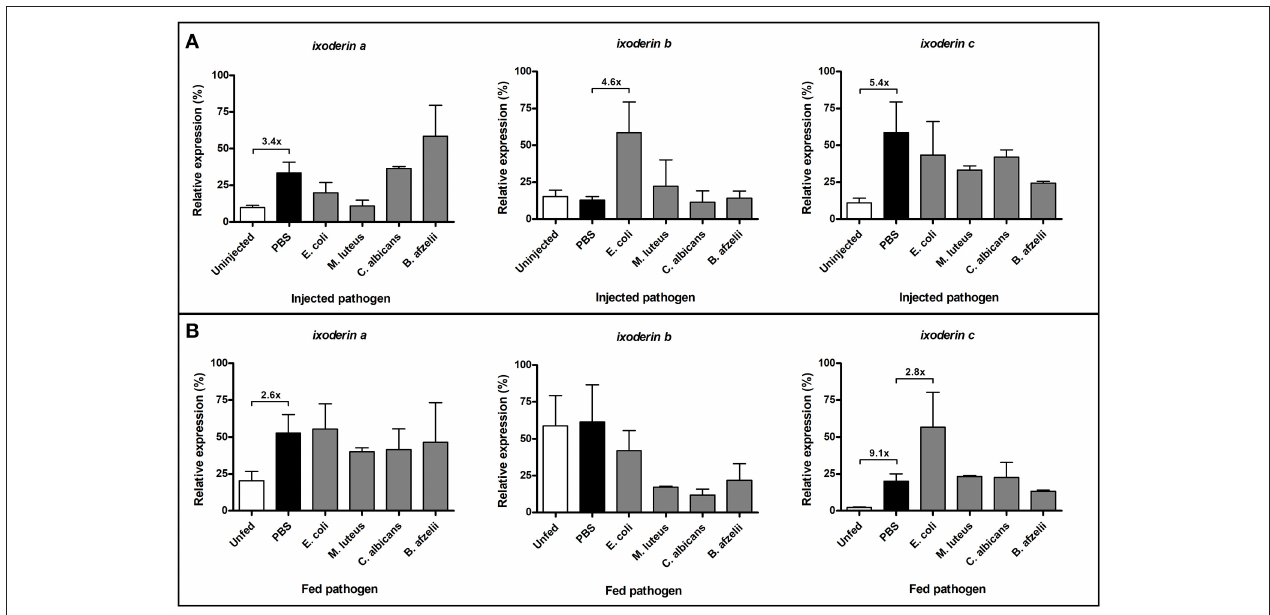
FIGURE 4 | Wounding and exposure to microbes alter expression of ixoderins . Gene expression was measured by qRT-PCR 12 hrs after pathogen injection or feeding. The analysis was performed using unfed adult females injected (A) or capillary fed (B) with pathogens. The samples were prepared in three biological replicates. In each graph, cDNA with the highest expression was set as 100% (relative expression). Tick actin was used as a housekeeping